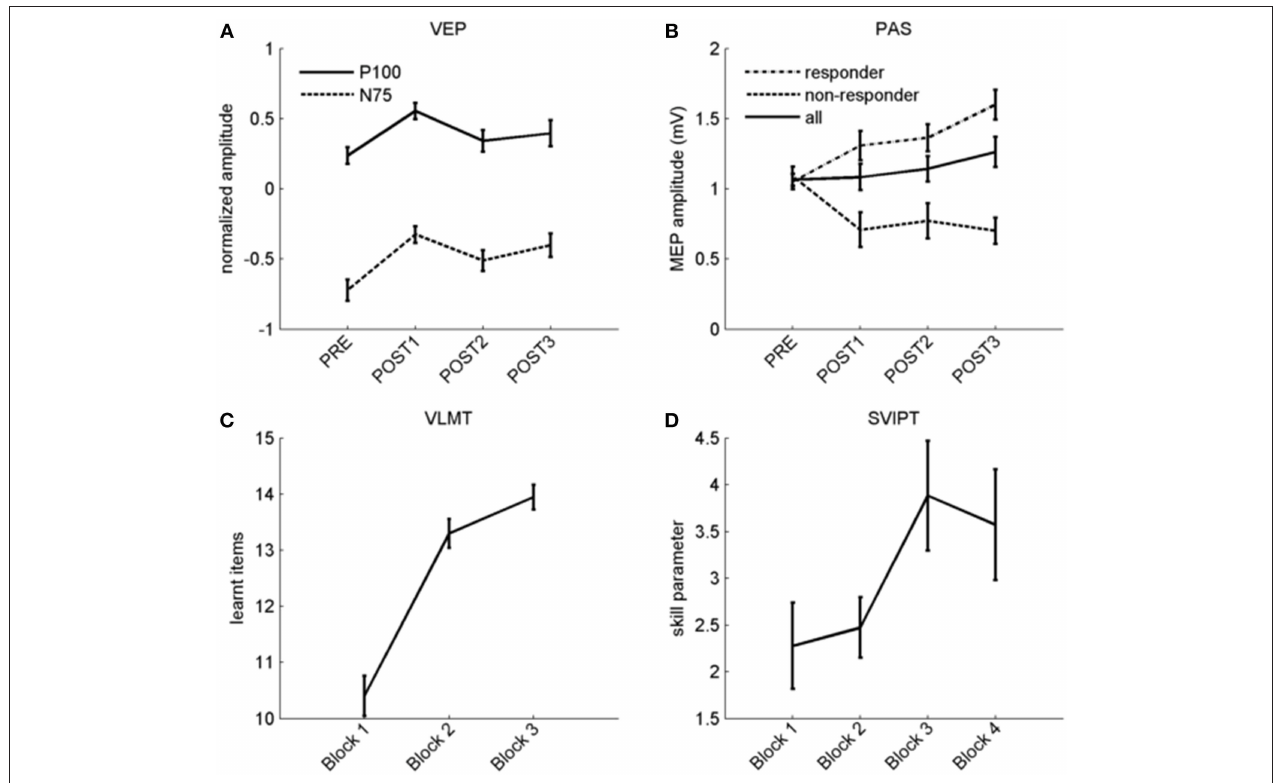
FIGURE 4 | Overview of plasticity protocols. (A) Normalized P100 (solid line) and N75 (dashed line) amplitudes before and after stimulation with checkerboard reversals. (B) MEP amplitude before and after PAS across all subjects (solid line), and separated in responders (dashed line) and non-responders (dotted line). (C) Verbal learning curve with three repetitions (x-axis). Number of learned items is shown on the y-axis. (D) Skill improvement during four blocks of motor learning, the slight drop in the fourth block is due to an increase of the error rate. For the whole figure, error bars indicate